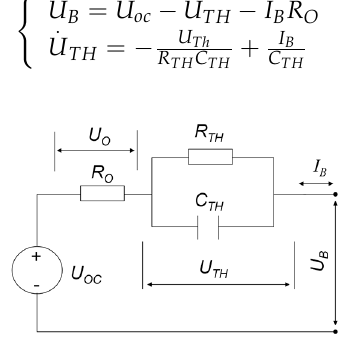
Figure 1. The equivalent circuit model.